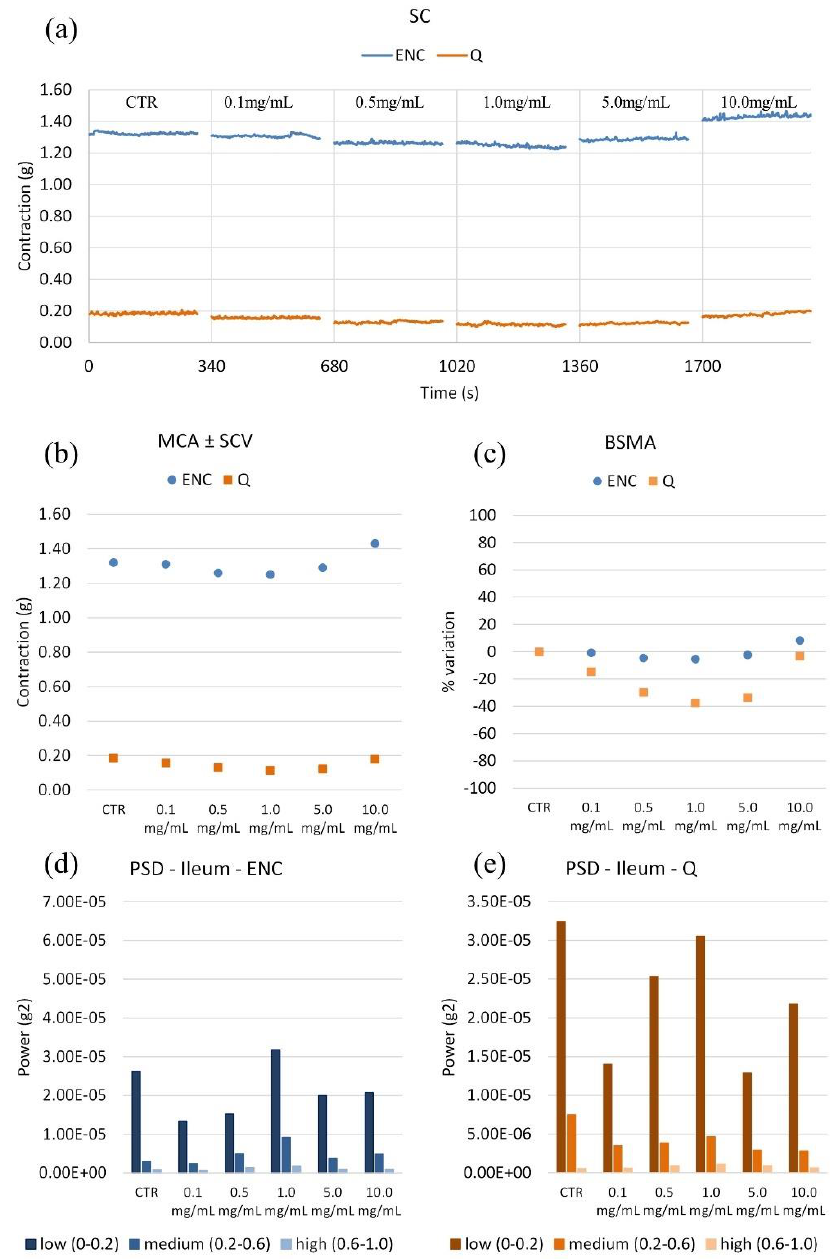
Figure 5. ( a ) Experimental original recording of the concentration–response curve of ENC ( Castanea sativa Mill.) and Q ( Schinopsis balansae Engl.) extract on ileum spontaneous contractility (SC). ( b ) Mean contraction amplitude (MCA) with spontaneous contraction variability (SCV). ( c ) Basal Spontaneous Motor Activity (BSMA). Zero represents the basal tone, and each point is the percent variation from the baseline after cumulative addition of each dose; each value is the mean ± SEM; when the error bar is not shown, it is covered by the point. ( c ) Power Spectral Density (PSD): ( d ) Ileum with ENC; ( e ) Ileum with Q.